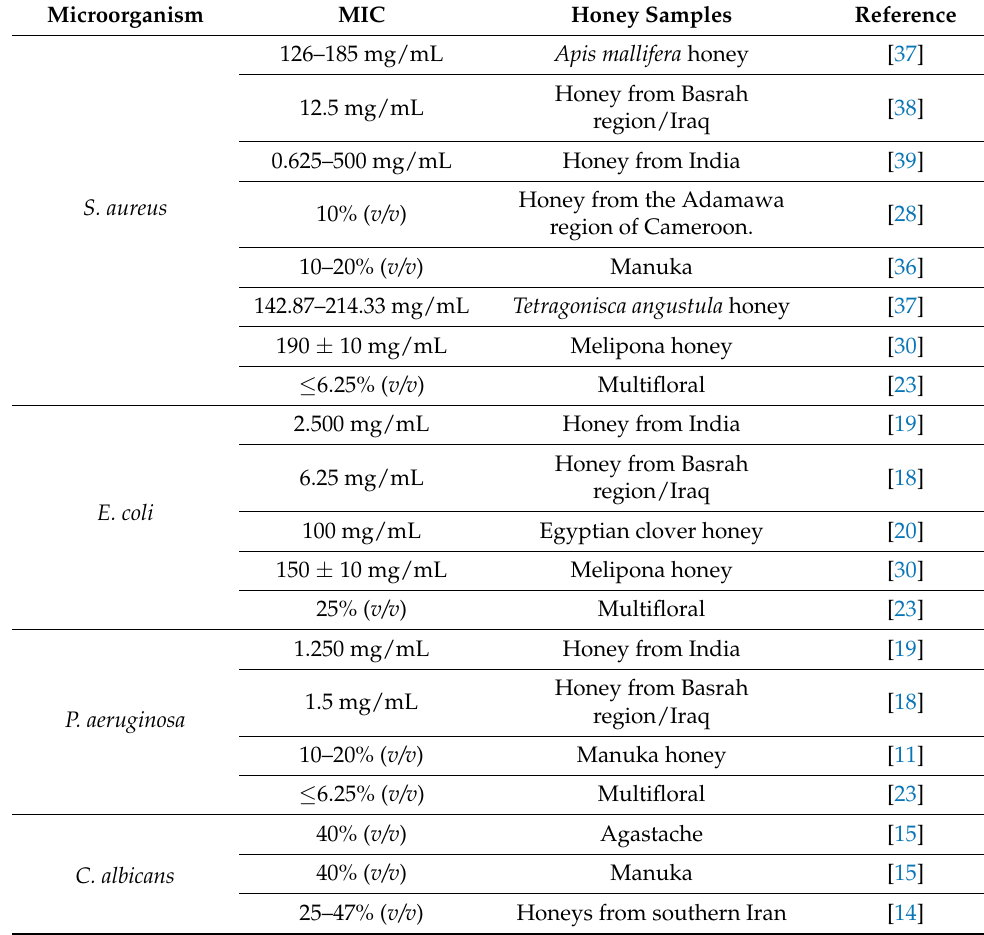
Table 1. Antibacterial activity of different